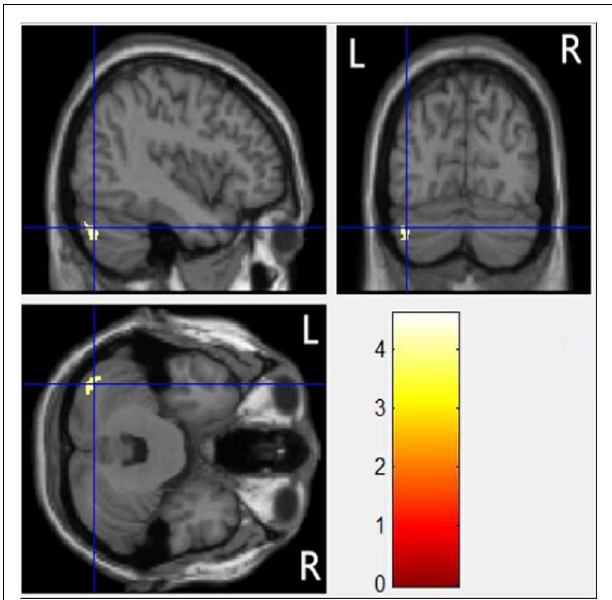
FIGURE 1 | Statistical parametric maps of whole-brain VBM analyses displayed on a template brain. A region in the left posterior cerebellum exhibited significantly reduced gray matter volume in the dyslexic group compared with